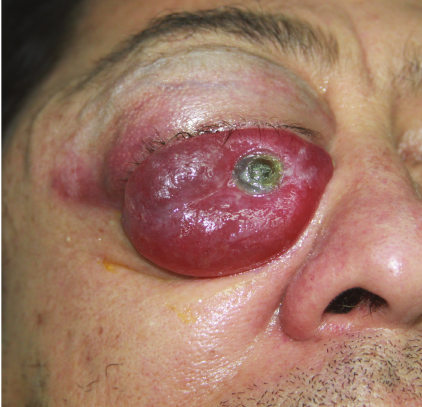
Figure 1: Patient at the onset with inferior displacement of the globe and severe conjunctival chemosis.